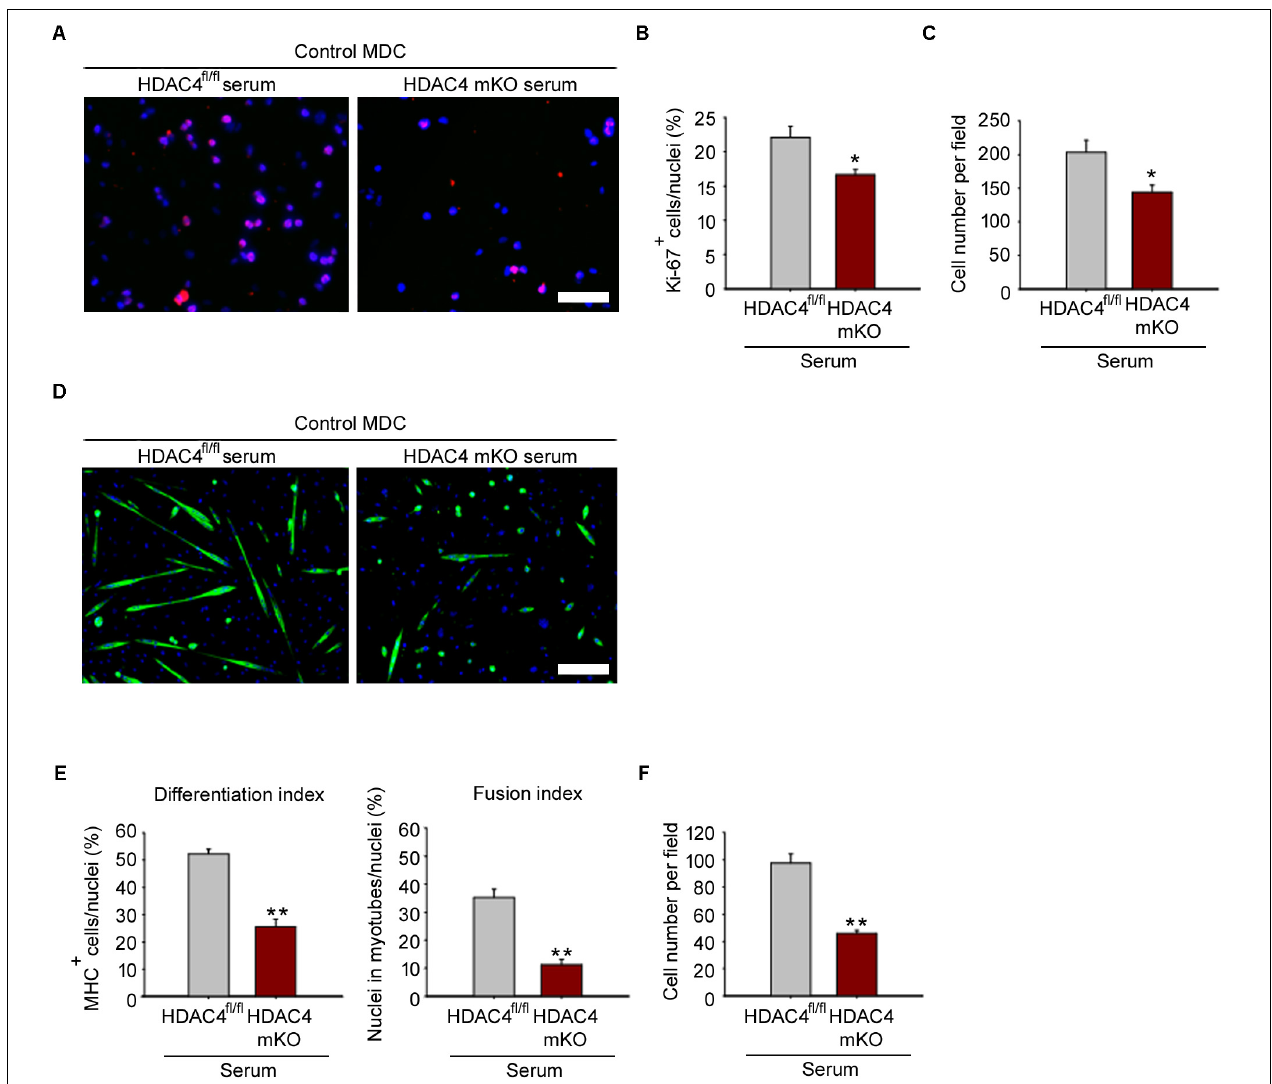
FIGURE 5 | HDAC4 mKO serum negatively affects control MDC proliferation and differentiation. (A) Representative pictures of immunofluorescence for Ki-67 in control MDCs, after 24 h in conditioned media with sera from either injured HDAC4 mKO or HDAC4 fl/fl mice. Scale bar = 50 µ m. (B) Quantification of the proliferating Ki-67 + cells, over the total cell number. Data are presented as mean +/– SEM. n = 6 mice for genotype. ∗ p < 0.05 by Student’s t -test. (C) Quantification of MDC number cultured with sera from either injured HDAC4 mKO or HDAC4 fl/fl mice. Data are presented as mean +/– SEM. n = 6 mice for genotype. ∗ p < 0.05 by Student’s t -test. (D) Representative pictures of immunofluorescence for MHC in control MDCs cultured with conditioned media with sera from either HDAC4 mKO or HDAC4 fl/fl injured mice, after 3 days in differentiation medium. Scale bar = 100 µ m. (E) Quantification of the differentiation and fusion indexes of control MDCs cultured with sera from either injured HDAC4 mKO or HDAC4 fl/fl mice, after 3 days in differentiation medium. Data are presented as mean +/– SEM. n = 6 mice for genotype. ∗∗ p < 0.005 by Student’s t -test. (F) Number of control MDCs cultured with sera from either injured HDAC4 mKO or HDAC4 fl/fl mice, after 3 days in differentiation medium. Data are presented as mean +/– SEM. n = 6 mice for genotype. ∗∗ p < 0.005 by Student’s t